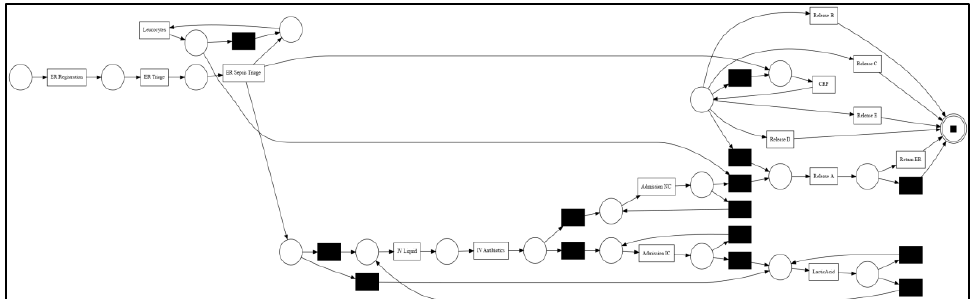
Figure 7. Petri net discovered by Split Miner from the Sepsis.